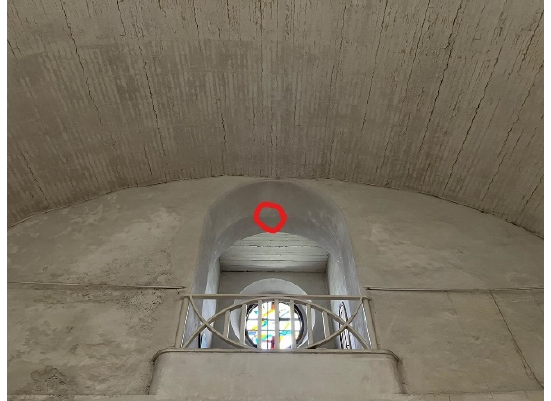
Figure 3. Example of mounting HOBO MX measuring instruments on the ceiling arch.